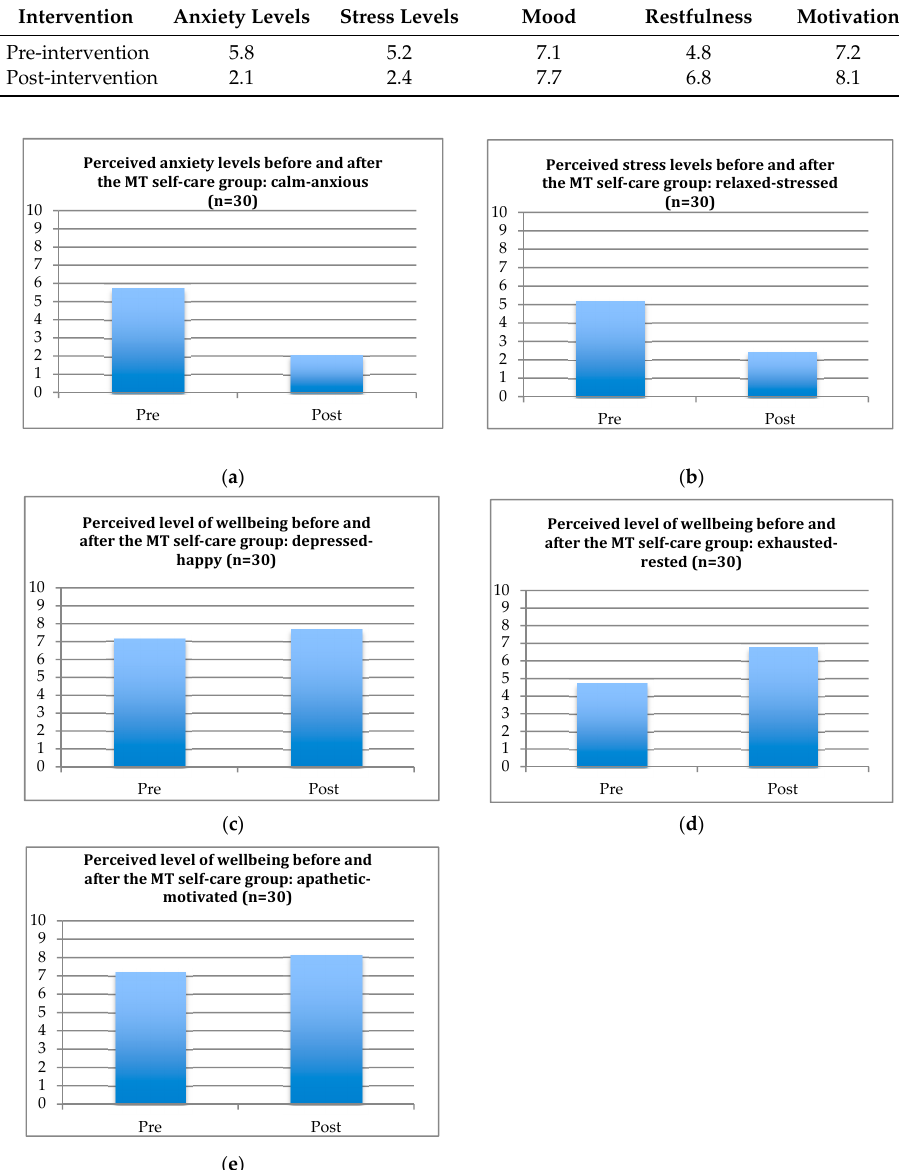
Figure 2. This figure shows the bar charts of the pre- and post-intervention results obtained with the NRS. Please note that the NRS was introduced at a later point, after the start of the clinical pilot program. This is why the data of 30 participants were collected via the NRS, but there were 122 participants in total. ( a ) This bar chart shows the perceived level of anxiety before and after the group sessions. A lower score indicates less perceived anxiety. ( b ) This bar chart shows the perceived level of stress before and after the group sessions. A lower score indicates less perceived stress. ( c ) This bar chart shows the perceived level of mood before and after the group sessions. A higher score indicates a better perceived mood. ( d ) This bar chart shows the perceived level of restfulness before and after the group sessions. A higher score indicates a better perceived feeling of restfulness. ( e ) This bar chart shows the perceived level of motivation before and after the group sessions. A higher score indicates a better perceived